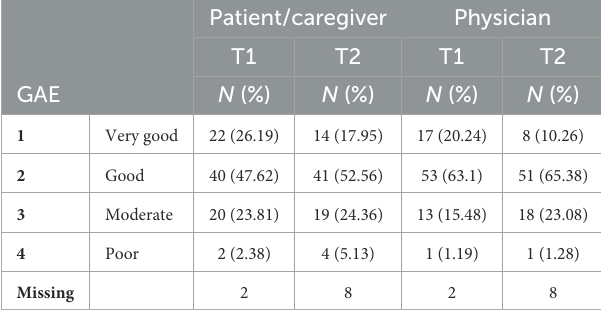
TABLE 5 BoNT-A treatment efficacy as reported by the patients/caregivers and the physicians.